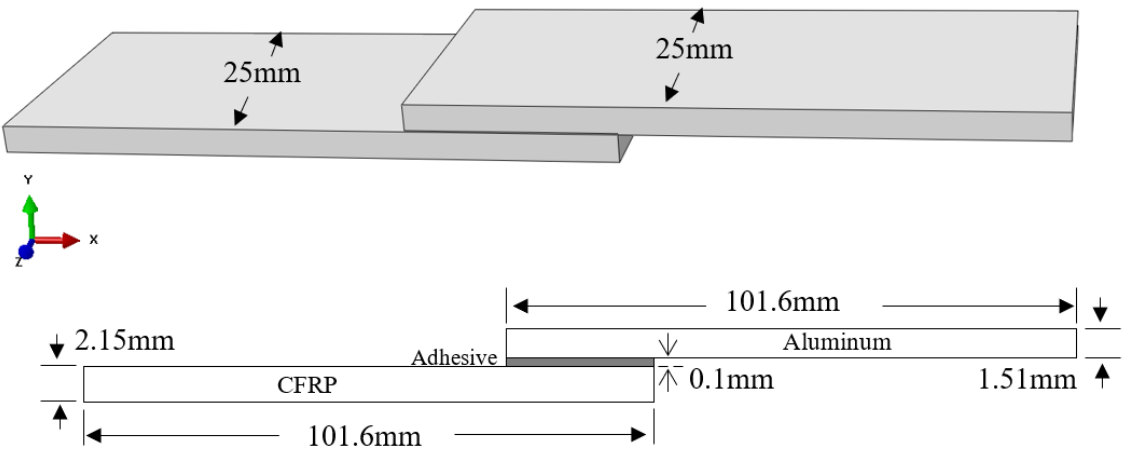
Figure 1. The geometry of single-lap joint (not to scale).